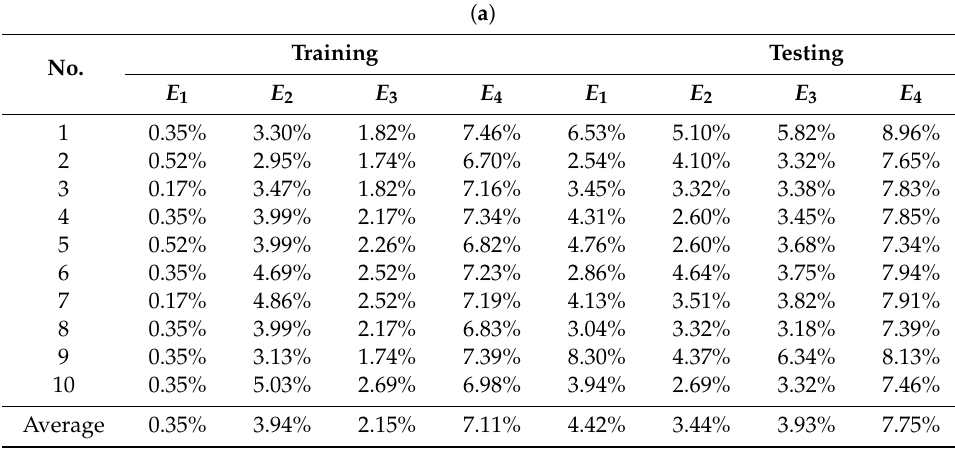
Table 5. Detection error rates of CSM compared with the reference method. ( a ) Twenty-five samples were trained and the rest of the samples were tested and repeated 10 times; ( b ) 50 samples were trained and the rest of the samples were tested and repeated 10 times; ( c ) 75 samples were trained and the rest of the samples were tested and repeated 10 times; ( d ) average statistics of 25, 50, and 75 training samples and testing results. STTTA, self-tuning triple-threshold algorithm; PM, proportional